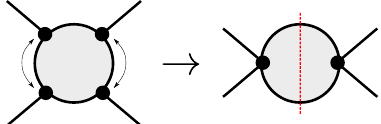
Figure 25: A cut can be found by connecting external vertices (represented in black) in pairs. Each pair turns into two vertices, source and sink , and the cut separat- ing external legs becomes a source-to-sink cut [ 11 ] which can be found using graph- theoretic algorithms [ 45 ]